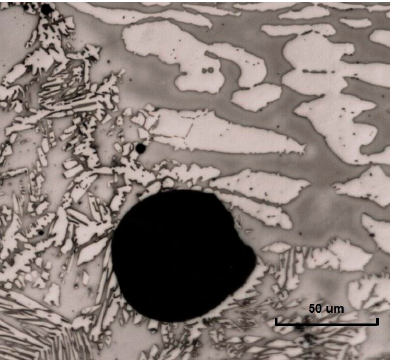
Figure 18. A pore (in black) surrounded in the majority of its perimeter by austenite phase (in